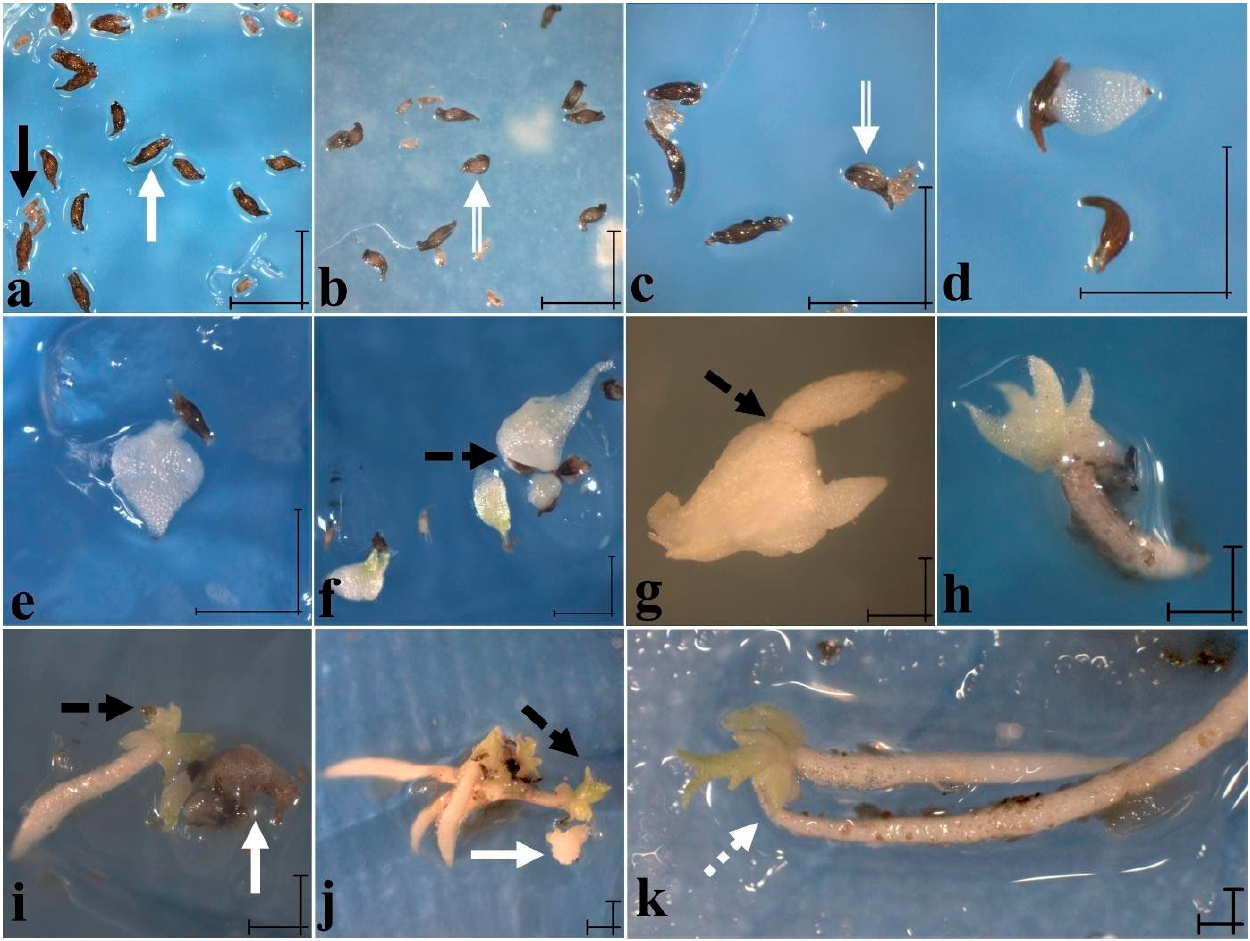
Figure 10. Asymbiotic in vitro germination of Cypripedium irapeanum in Norstog medium. ( a ) Development stage 0 on day of sowing (black arrows show immature and undeveloped seeds and white arrows show mature seeds). ( b ) Imbibed seeds two days after sowing (das) (white arrow) (development stage 1). ( c ) Imbibed seed with rupture of testa 12 das (white arrow) (development stage 2). ( d ) Protocorm polarization with apical meristem at 45 das (upper structure) (developmental stage 3). ( e ) Protocorm development with leaf blade at 54 das (developmental stage 4). ( f ) Pre-seedling showing radical meristem (black dashed arrow) and a long achlorophyllous leaf 96 das (developmental stage 5). Other chlorophyll pre-seedlings with two leaf blades are located at the bottom left. ( g ) Seedling development with two incipient roots at 122 das (black dashed arrow) (developmental stage 6). ( h ) Seedling 187 das with four leaves and a greater ratio between root and shoot. ( i ) Seedling 300 das with lateral shoots and remnant testa (black dashed arrow) from the first shoot and two radical sprouts. The white arrow shows two oxidized pre-seedlings at stage 4. ( j ) Four seedlings 300 das with long roots and one seedling with two shoots (black dashed arrow). The white arrow shows a protocorm with irregular protuberances, such as rhizoids, or a protocorm-like body (PLB). ( k ) Seedling at 365 das with three shoots and two elongated and exfoliant rhizodermic roots. Scale bars = 100 µm.